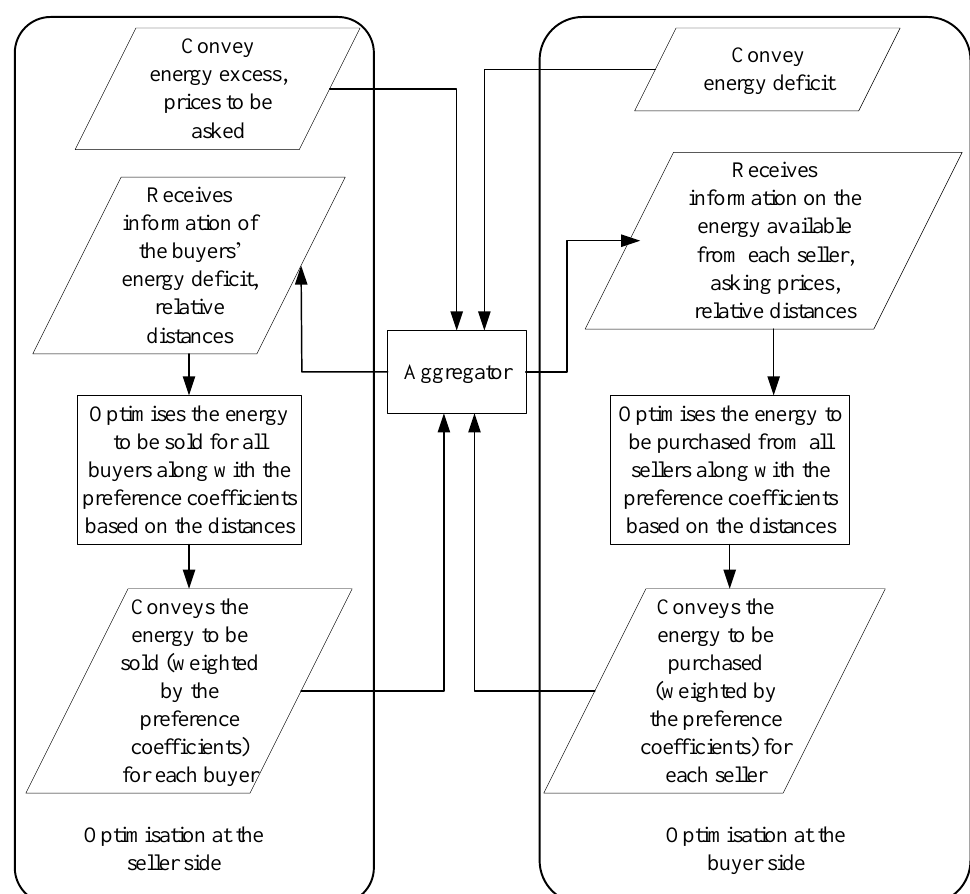
Figure 1. Optimisation of preference coefficients at sellers and